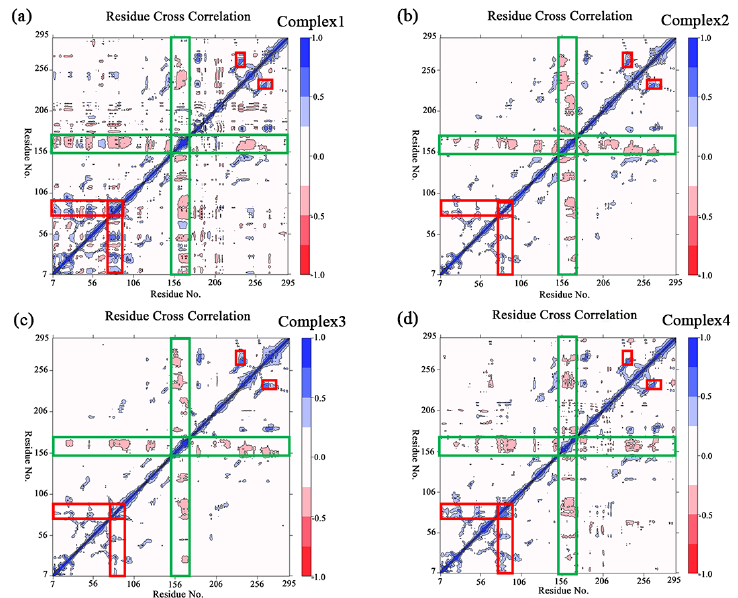
Figure 5. ( a – d ) The plot of the covariance matrix for the complexes 1–4, the red–to–blue bar legend represents the degrees of correlation between residues, where blue indicates a positive correlation and red indicates a negative correlation. Several significant areas of correlated motion are highlighted with rectangles, of which the negative correlation is circled in green, and the positive correlation is circled in red.